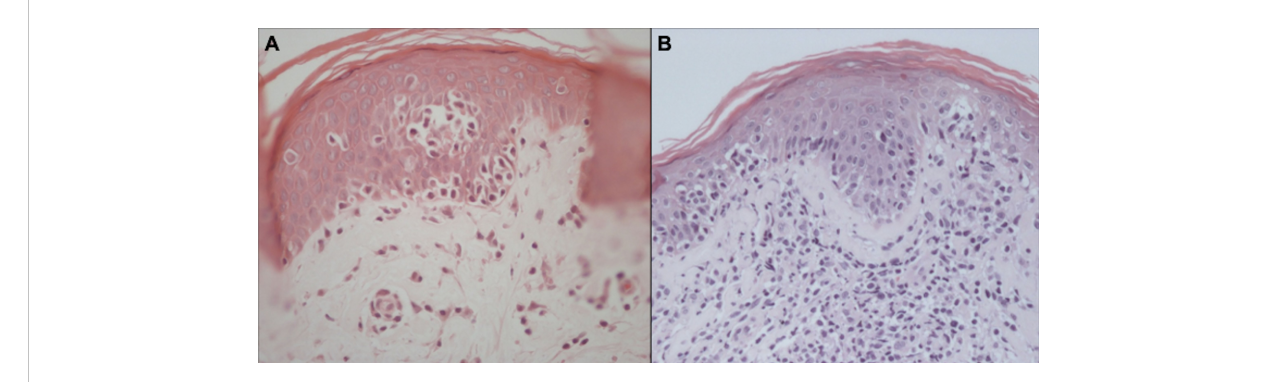
FIGURE 10 Histopathology of MF. Epidermotropism of atypical lymphocytes with Pautrier microabscess and scant dermal lymphocytic in fi ltrate (A) . Epidermotropism, Pautrier microabscesses, and a more prominent dermal lymphocytic in fi ltrate (B) .